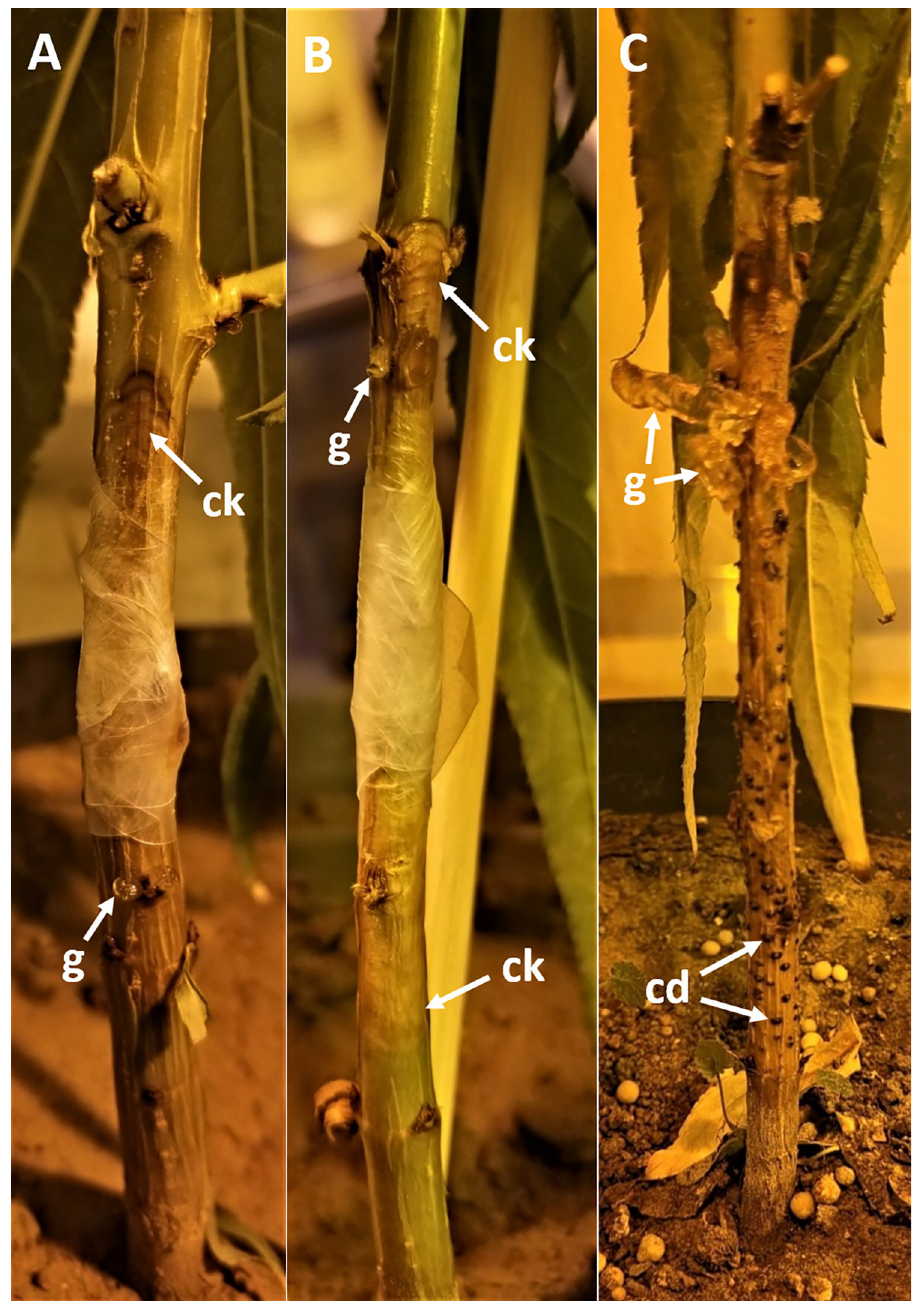
Fig 7. Symptoms of Cytospora paraplurivora infection on Prunus persica var. persica seedlings including A) 5-day old canker (ck) and gummosis (g); B) 7-day old canker; and C) 27-day old canker, conidiomata (cd) and gummosis. The symptoms caused by the new species resemble the leucostoma canker disease (peren- nial canker) of stone fruits, a widespread plant disease affecting crop yield in Canada and some regions of USA. C . leucostoma and C . cincta were found to be associated with this disease [68] and the species were identified solely by morphological characteristics. The studies on Cytos- pora spp. with the ITS sequence data refined the species identification of the leucocytosporoid